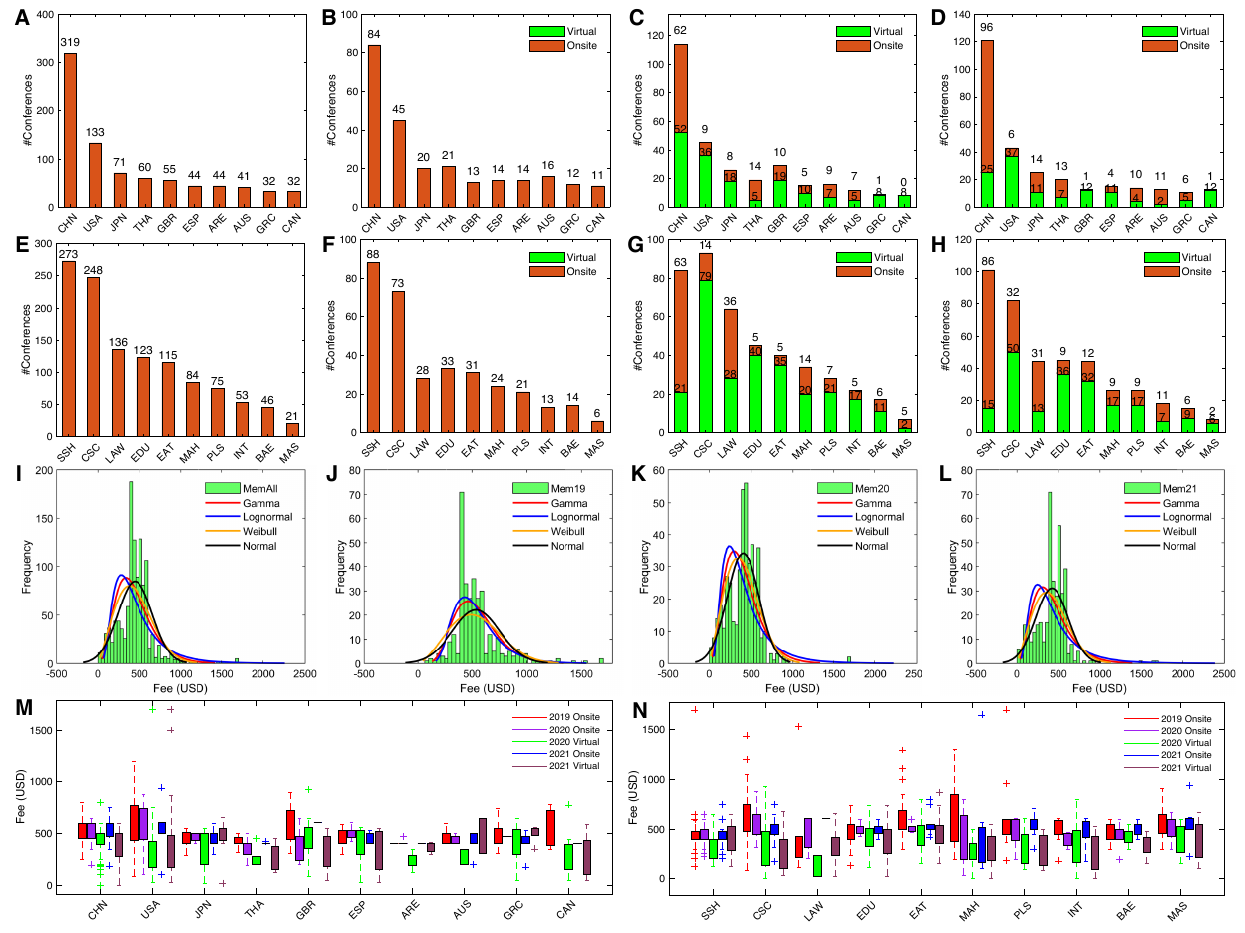
Figure 1. Statistical results of the conferences held in 2019, 2020 and 2021. ( A ) The top 10 countries ranked by the number of conferences held over the three years. ( B – D ) The number of virtual and onsite conferences held in 2019, 2020, and 2021 with respect to the top 10 countries. ( E ) Ranking of the disciplines in terms of the number of conferences held over the three years. ( F – H ) The number of virtual and onsite conferences respectively held in 2019, 2020, and 2021 with respect to each